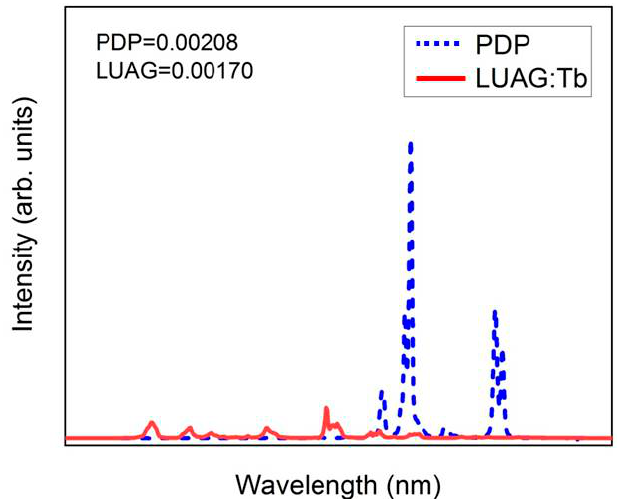
Figure 9. X-ray induced emission spectra of LuGd 2 Ga 2 Al 3 O 12 :Tb 3 + and plasma display panel (PDP) (Gd 2 O 2 S:Tb 3 + ).